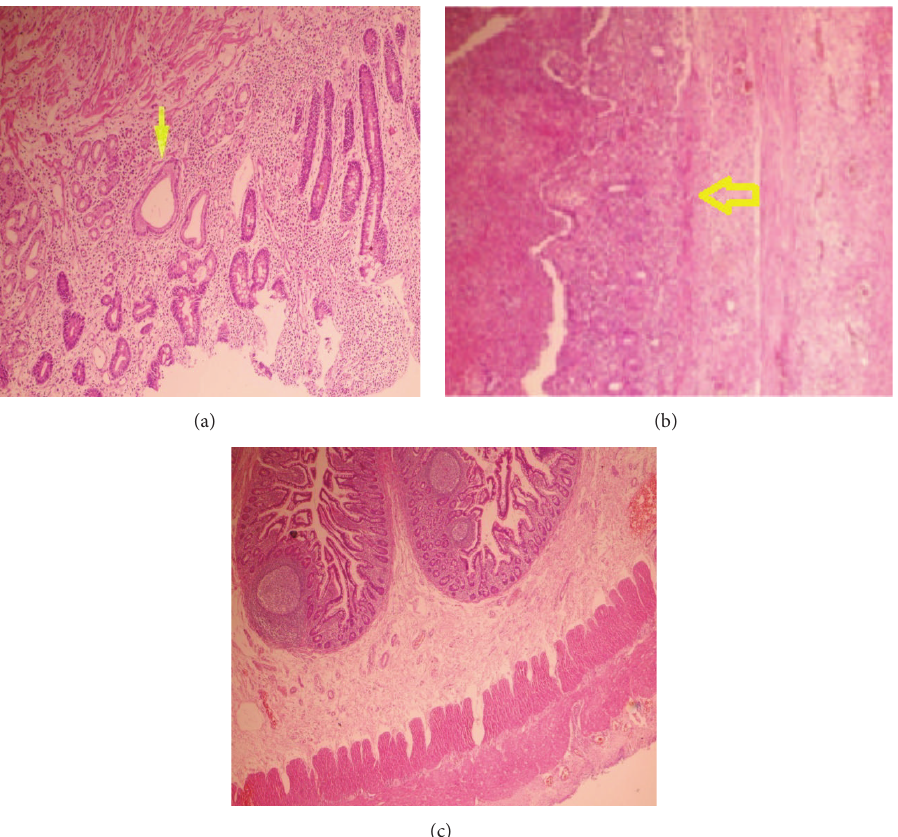
Figure 2: (a) Gastric mucosa (arrow), at the side of ulcerated intestinal mucosa (HE × 100). (b) Ulcerated intestinal wall (HE × 200). (c) Histopathology of the second diverticulum (HE ×